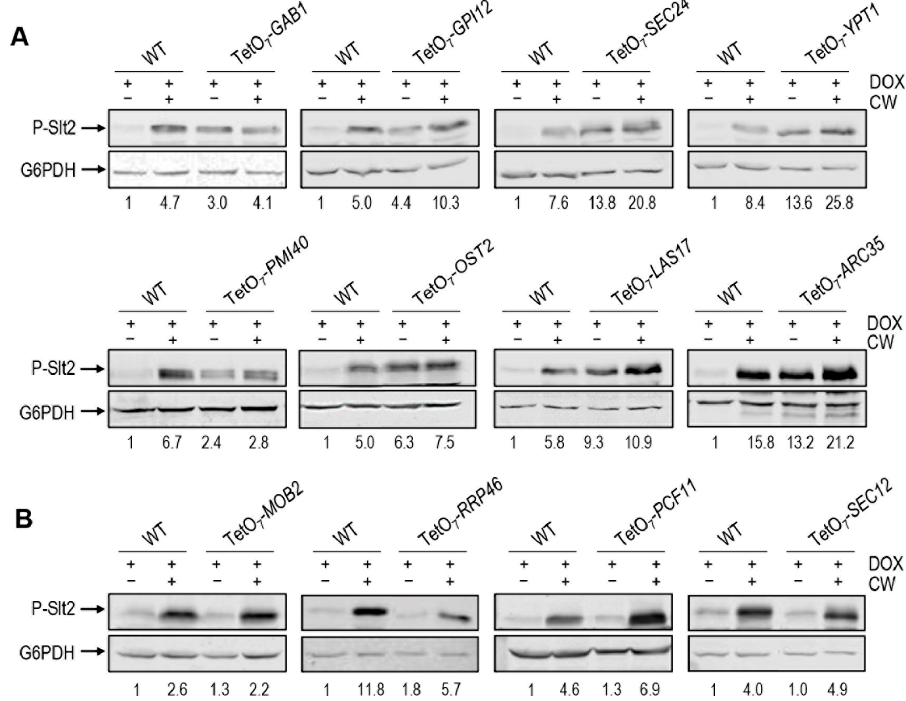
Figure 5. Detection of increased levels of Slt2 phosphorylation (P-Slt2) in the absence of cell wall stress. ( A ) Example of mutants displaying increased P-Slt2 basal levels. ( B ) Examples of mutants without P-Slt2 alteration. Cells exposed to doxycycline 10 µ g/mL (DOX) treated or not with Calcofluor white 10 μ g/mL for 3 h (CW) of the indicated yeast strains were taken and processed. Western blots detecting P-Slt2 with G6PDH as loading control are shown. Numbers correspond to the P-Slt2 fold-change obtained from densitometric quantification of the P-Slt2 bands normalized against G6PDH bands, using the values of the wild-type strain (WT) grown in the absence of CW as a reference (fold-change set to 1.0).